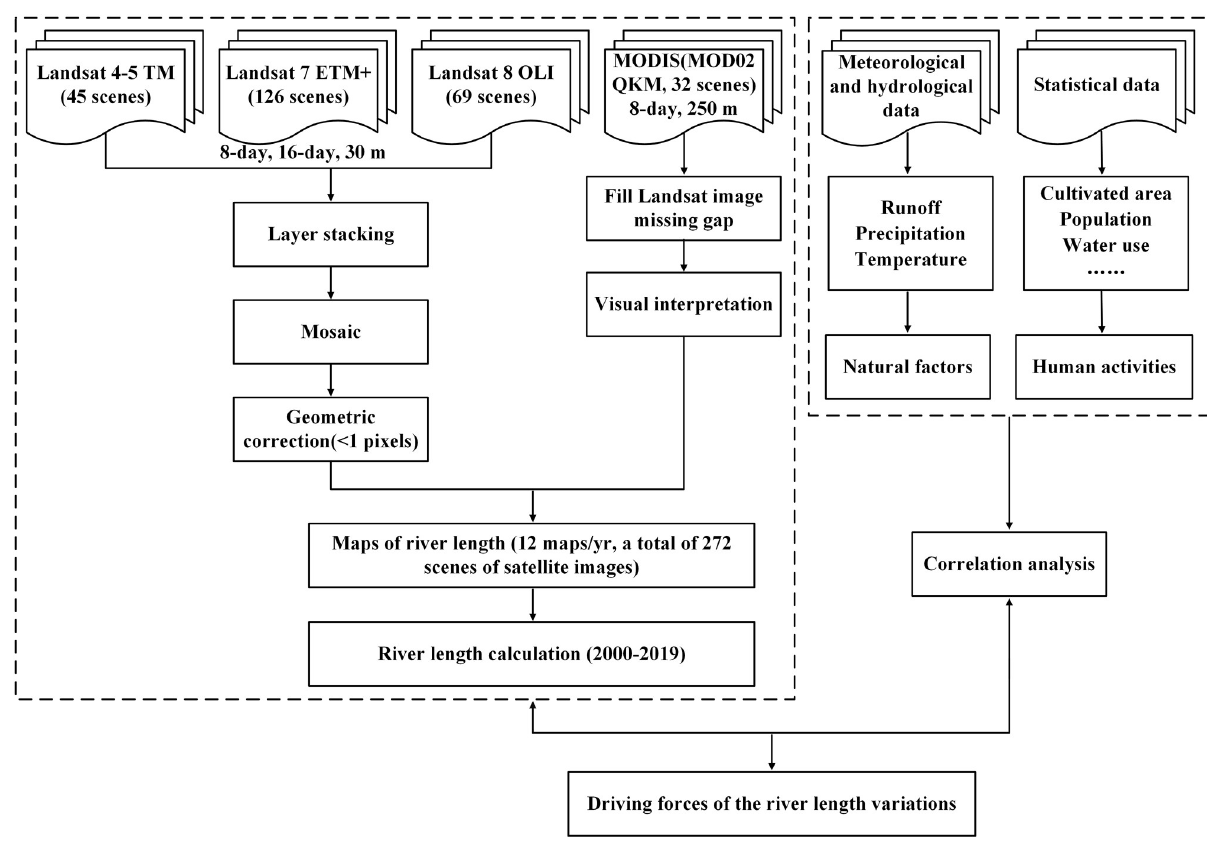
Fig 5. Schematic diagram of overall workflow, including processing of the remote-sensing data, the mapping and measurement of river length, and the analyses of the collected data.